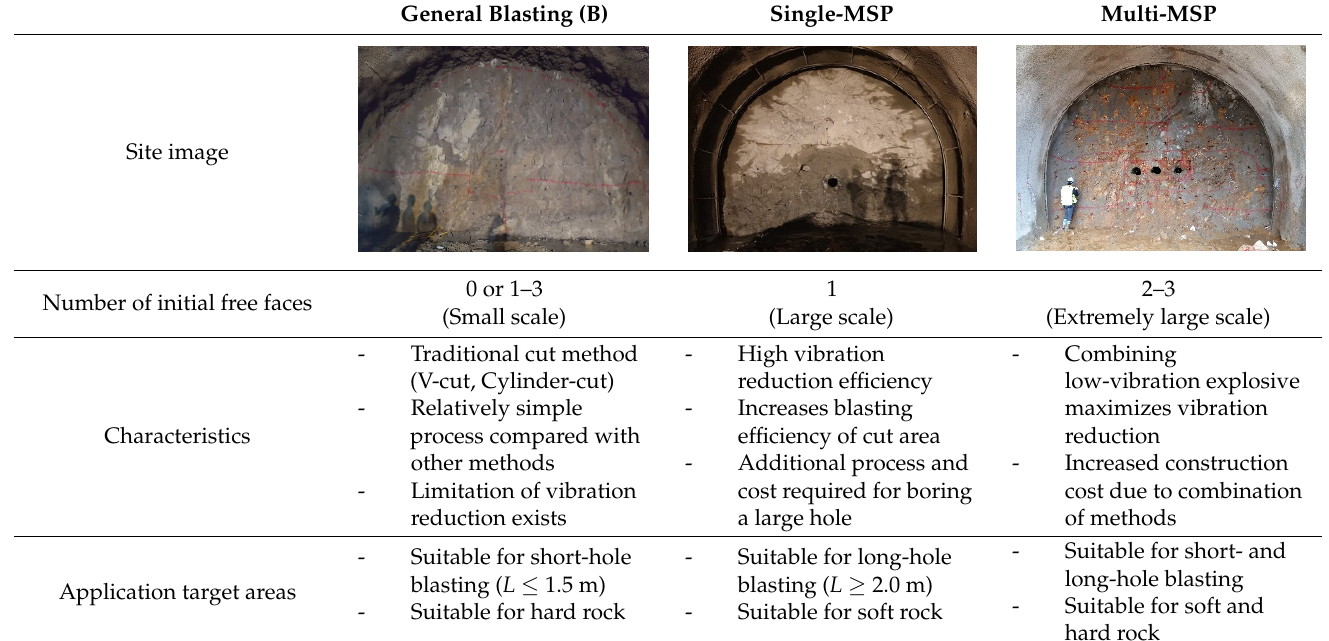
Table 1. Comparison of characteristics of cut blasting methods.